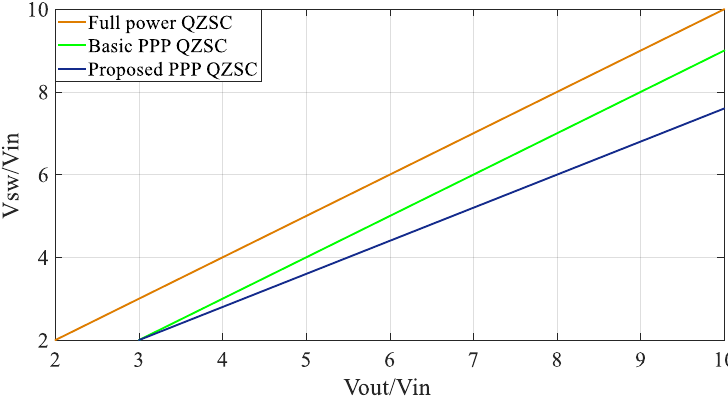
Figure 6. MOSFET voltage stress / input voltage versus voltage gain for FP-QZSC, basic PP-QZSC, and modified PP-QZSC (Transformer turn ratio=1) .